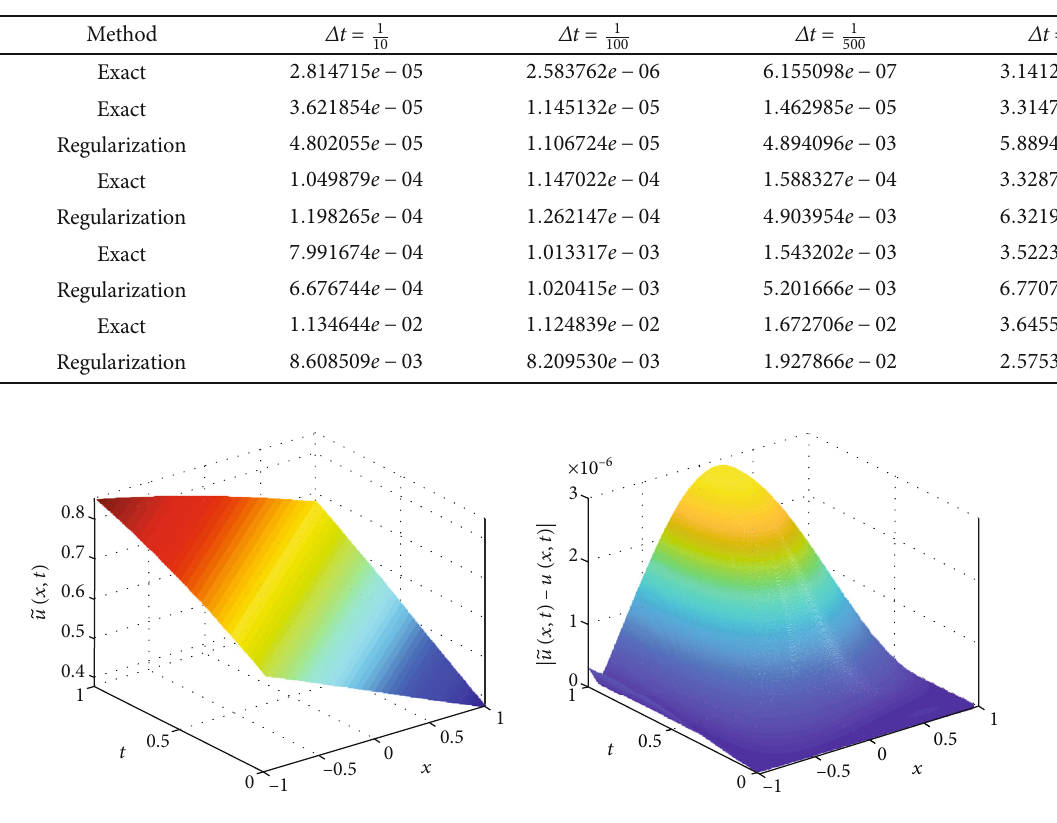
ff erent values of Δ t and ϑ with h = 0 : 05 .